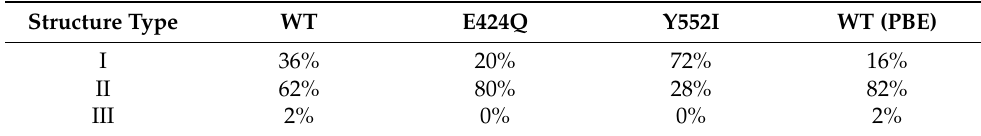
Table 3. Fractions of the NBO structures of types I, II and III (see Figure 8 for further details) obtained from the sets of 50 frames along QM/MM MD trajectories at the ES configuration for the WT, E424Q and Y552I species calculated at the PBE0 level and the ES WT complex calculated at the PBE level. Structure